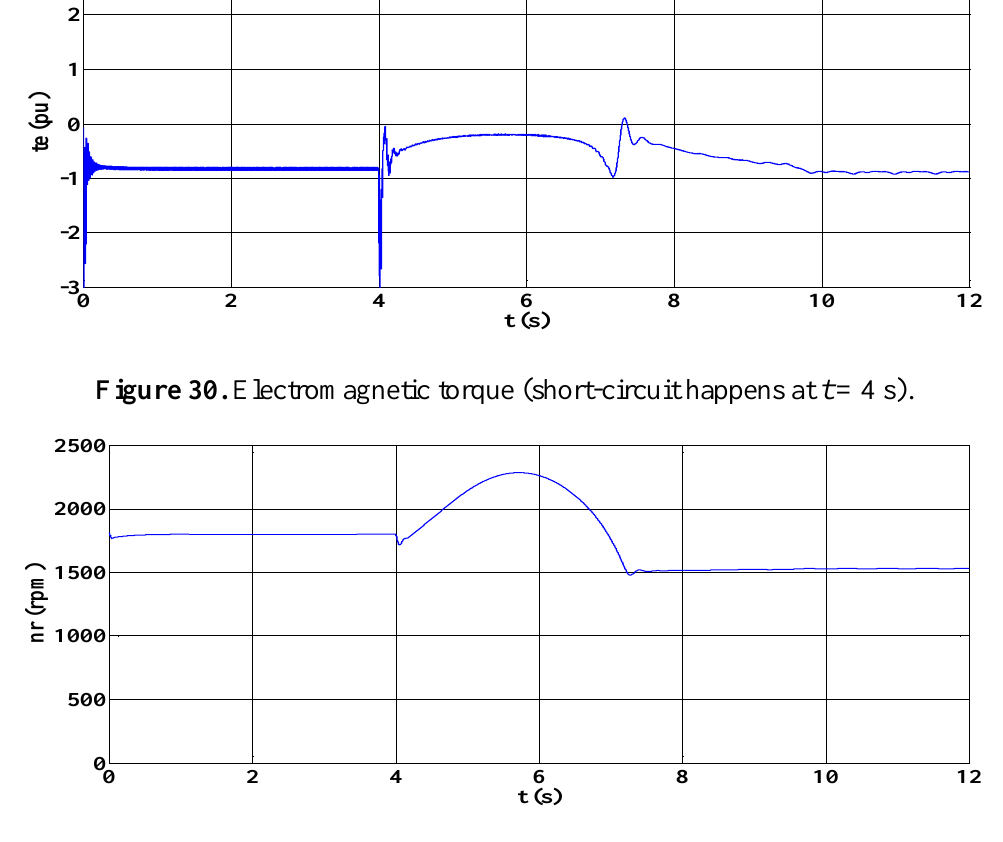
Figure 31. Rotor speed n r (short-circuit happens at t = 4